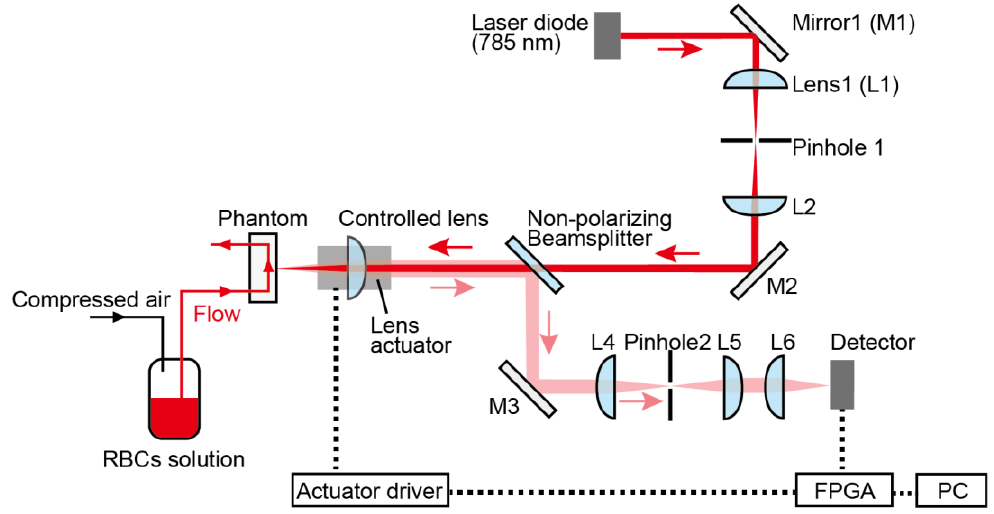
Figure 4. Confocal optical configuration of motion tracking LDF system. A 785-nm-wavelength probe beam is emitted from the diode laser. The controlled lens is mounted on the lens actuator, and is driven by the feedback signal from field-programmable gate array (FPGA).